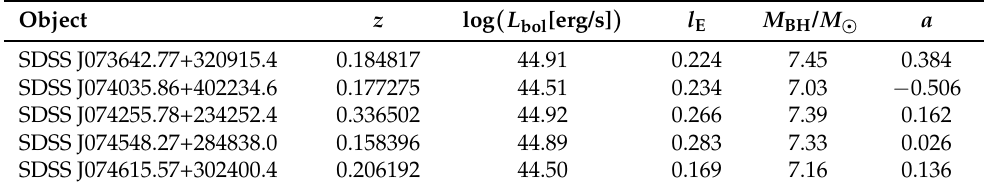
Table A2. All objects with their estimated spin values. Part 2 of